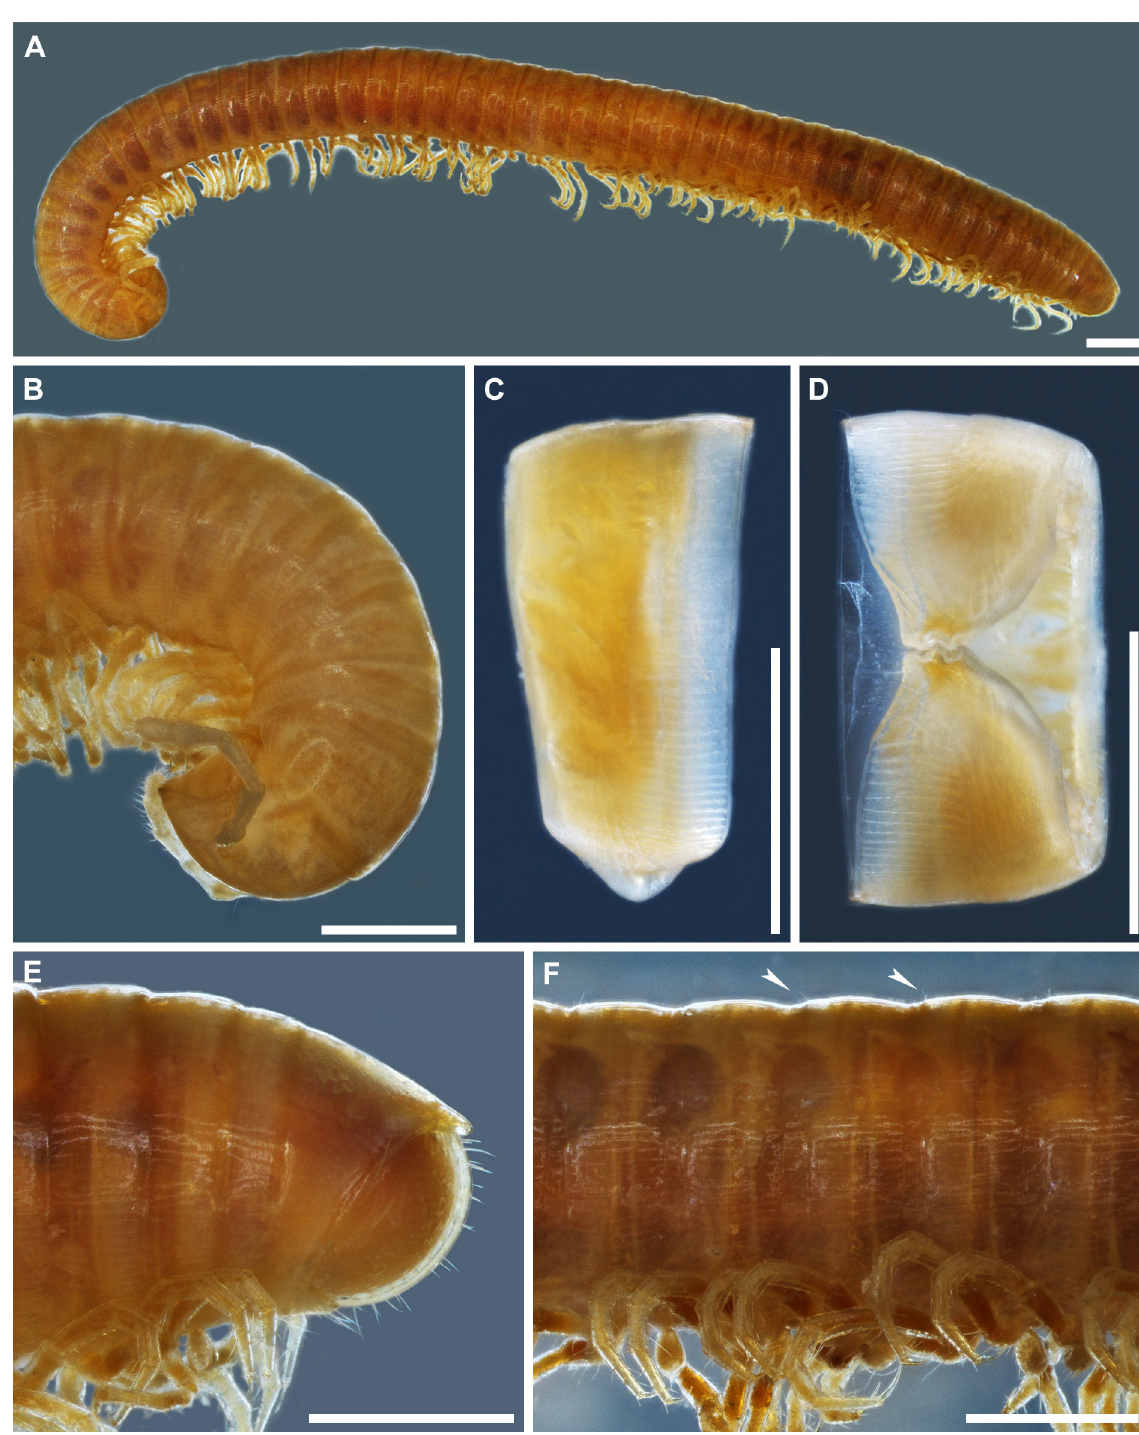
Fig. 3. Leucogeorgia abchasica (Lohmander, 1936) comb. nov., ♂♂ from Abraskila Cave (ZMUM). A . Habitus, lateral view. B . Anterior part of body, lateral view. C . Body ring 7, lateral view. D . Body ring 7, ventral view. E . Posterior part of body, lateral view. F . Midbody rings, lateral view. Arrows indicate metazonal setae. Scale bars: 1